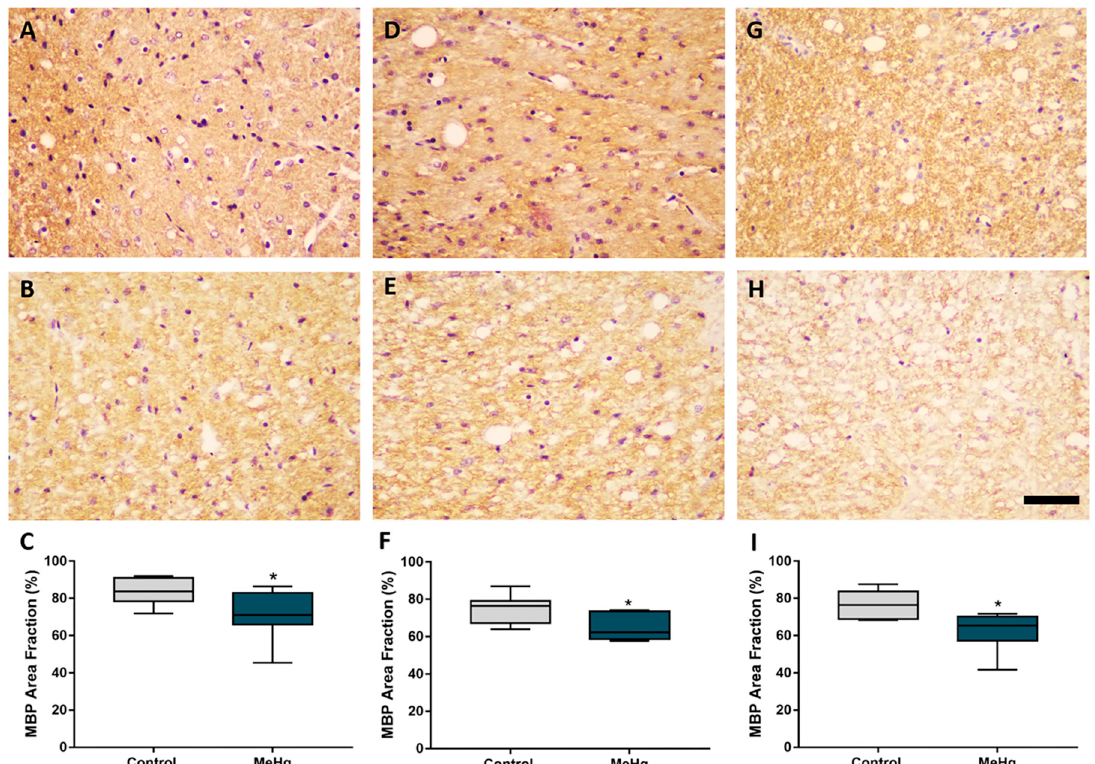
Figure 3. Exposure to MeHg caused a reduction in the immunomarked area in myelin basic protein in all areas evaluated. Effect of MeHg on the cervical ( A – C ) , thoracic ( D – F ) and lumbar ( G – I ) segments of the spinal cord in the offspring rats ( n = 7 animals per group) after exposure during the intrauterine and lactation period to 40 μ g/kg/day of MeHg (samples collected 21 days after 42 days of dosing). ( A , D , G ) are representative photomicrographs of the assessment of the fraction of area immunolabeled by anti-myelin basic protein (MBP) in the control group and ( B , E , H ) in the exposed group. Counterstaining with Harris hematoxylin. In ( C , F , I ) are the results of the MBP area fraction, expressed as the mean and interquartile deviation ( n = 7–8 animals per group). * p < 0.05, Mann–